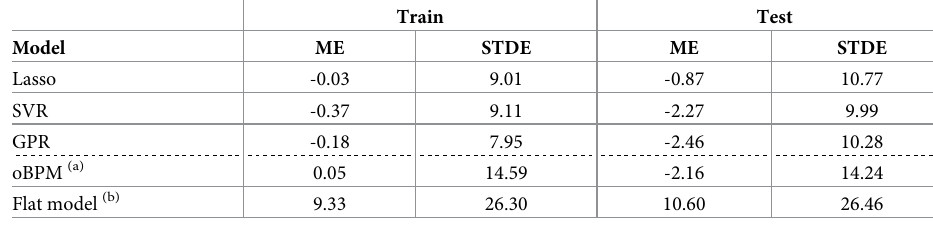
Table 3. SBP estimation performance in mmHg.